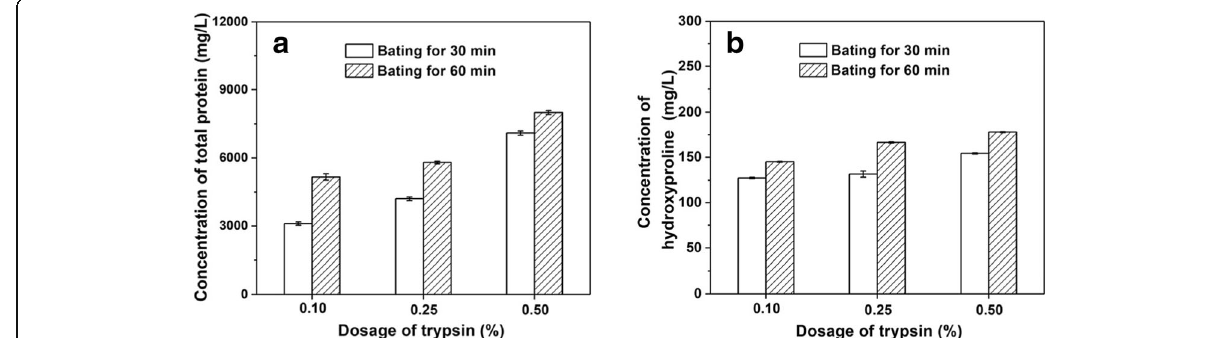
Fig. 3 Effects of trypsin dosage on concentrations of total protein ( a ) and hydroxyproline ( b ) in bating